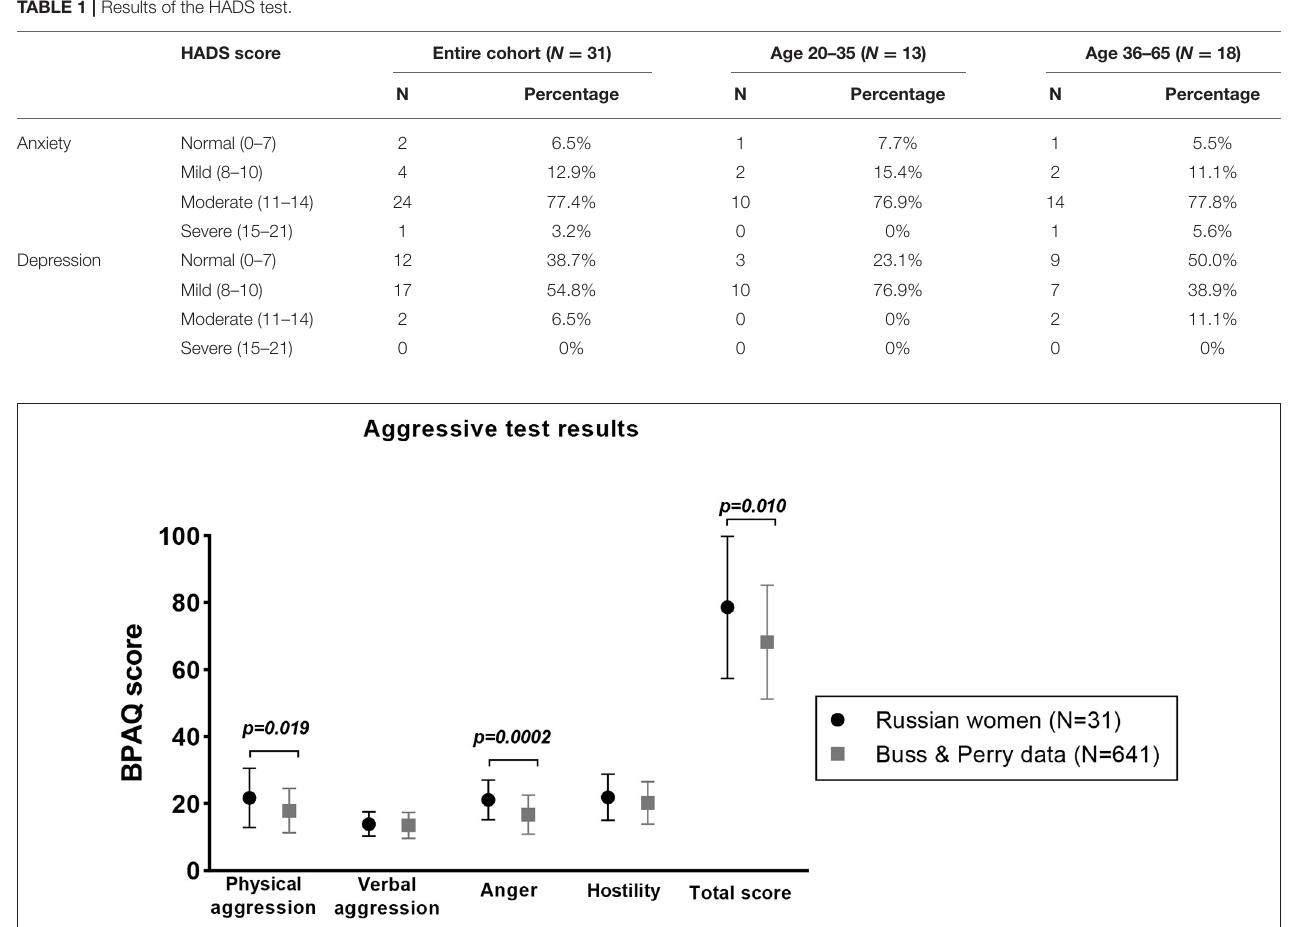
FIGURE 1 | Mean value ± SD of BPAQ score in Russian women compared to Buss and Perry